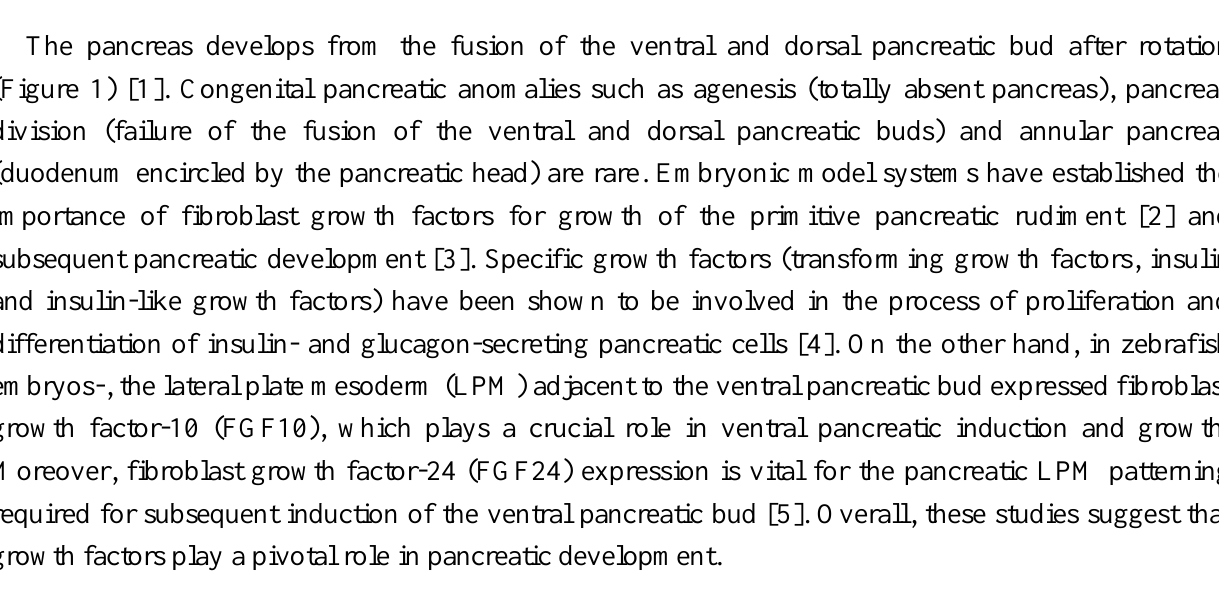
Figure 1. The pancreas is developed from fusion of ventral and dorsal